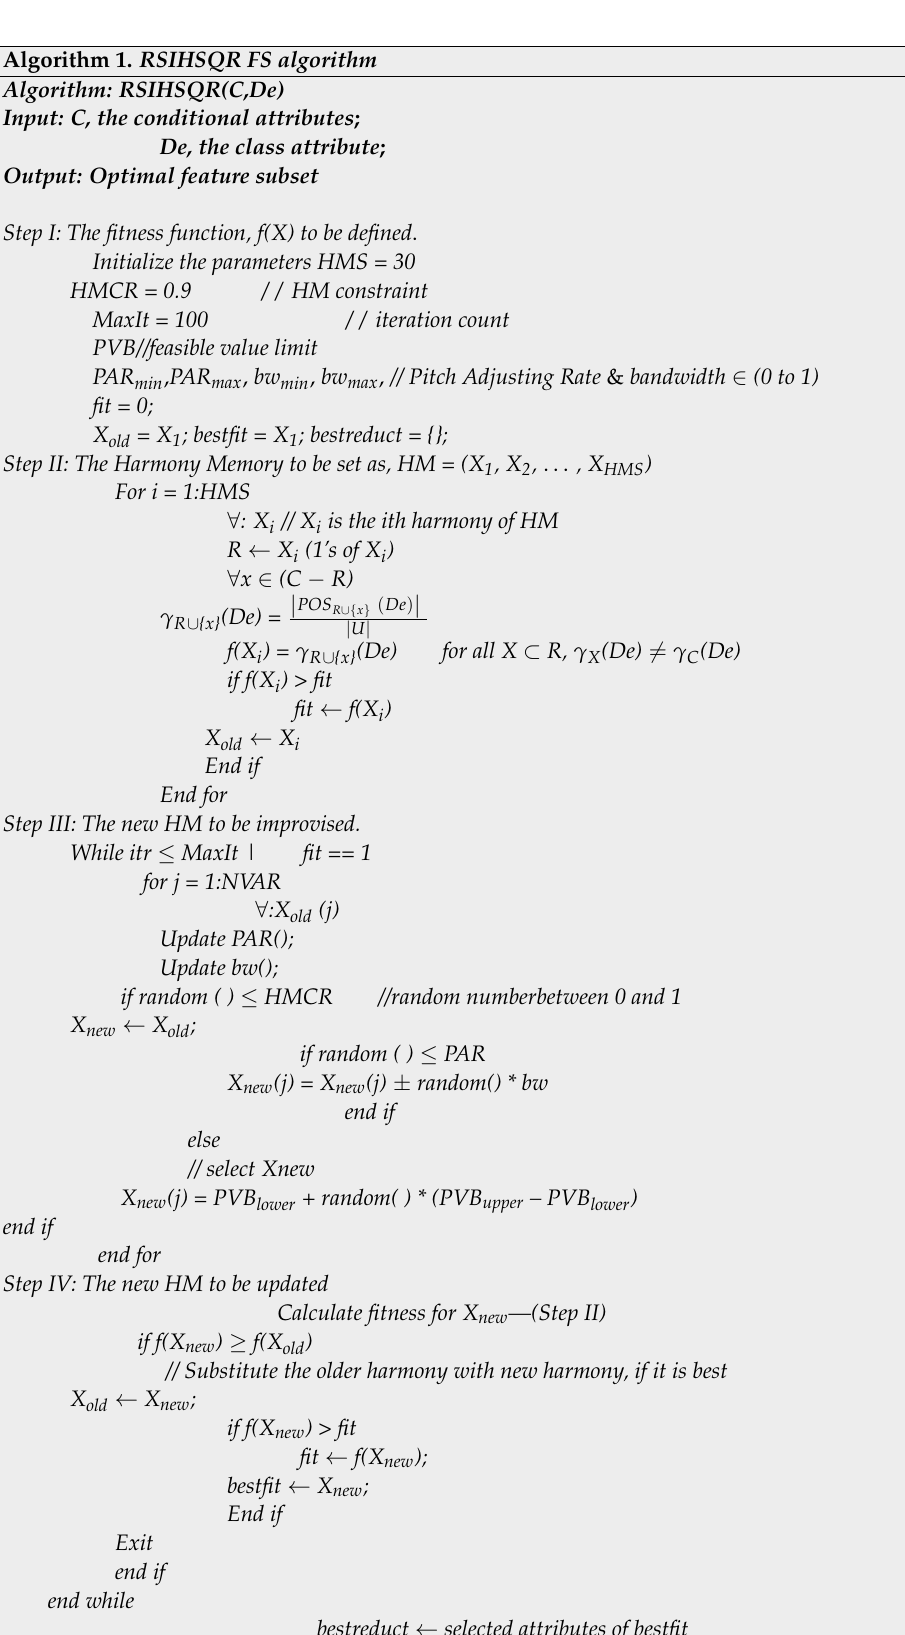
Algorithm 1. RSIHSQR FS algorithm Algorithm: